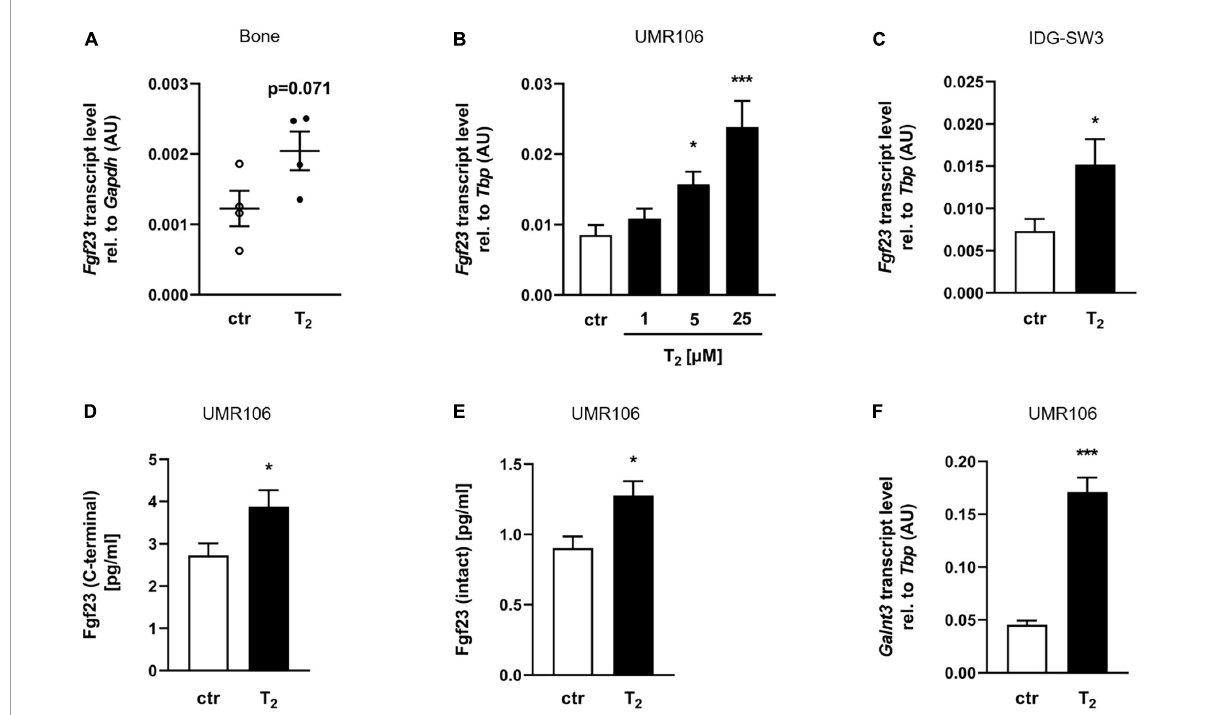
FIGURE2 Tachysterol 2 induces Fgf23 production in bone cells. (A) Scatter dot plots and arithmetic means ± SEM of relative (rel.) Fgf23 mRNA abundance (normalized to Gapdh ) in bone of wild-type mice ( n = 4) receiving diets with 0 or 4 mg/kg tachysterol 2 (T 2 ) for 2 weeks. Arithmetic means ± SEM of rel. Fgf23 ( B n = 8; C n = 11) and Galnt3 ( F n = 5) mRNA abundance (normalized to Tbp ) or cell culture supernatant concentrations of C-terminal ( D n = 10) or intact Fgf23 protein (E n = 11) in UMR106 osteoblast-like cells (B,D,E,F) and IDG-SW3 osteocytes (C) treated with T 2 ( B indicated concentrations; C–F 25 µ M T 2 ) for 24 h. * p < 0.05 and *** p < 0.001 indicate significant differences from the control. AU, arbitrary units; ctr, control ( A , D , E unpaired Student’s t -test; B Kruskal-Wallis ; C,F unpaired Student’s t -test with Welch’s